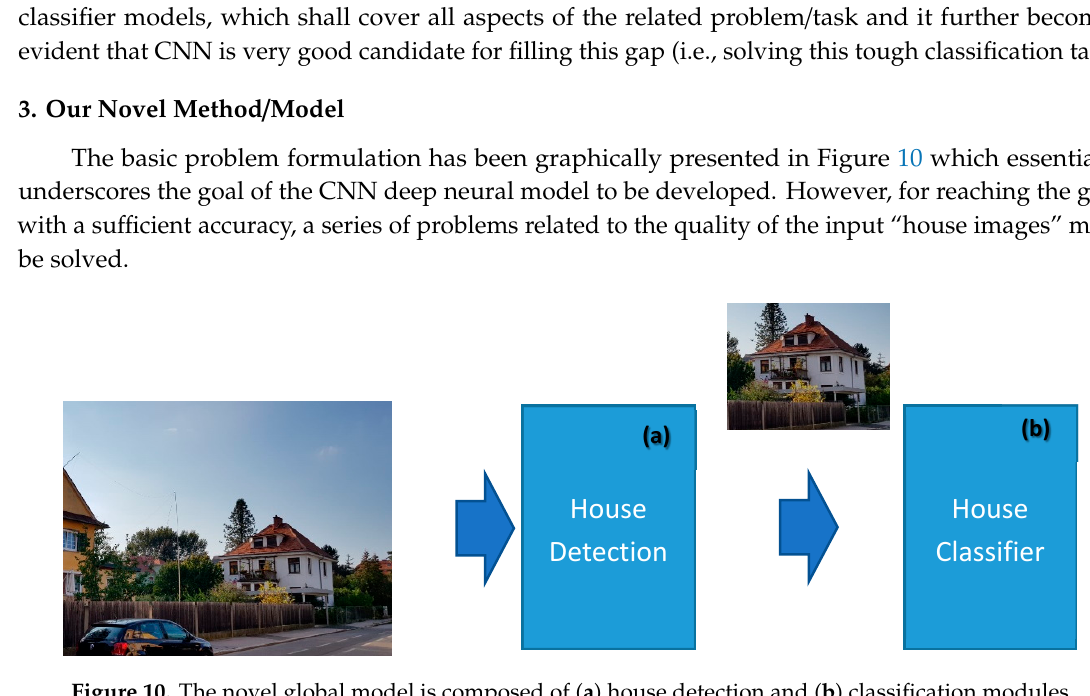
Figure 10. The novel global model is composed of ( a ) house detection and ( b ) classification modules. (Source: our own images).